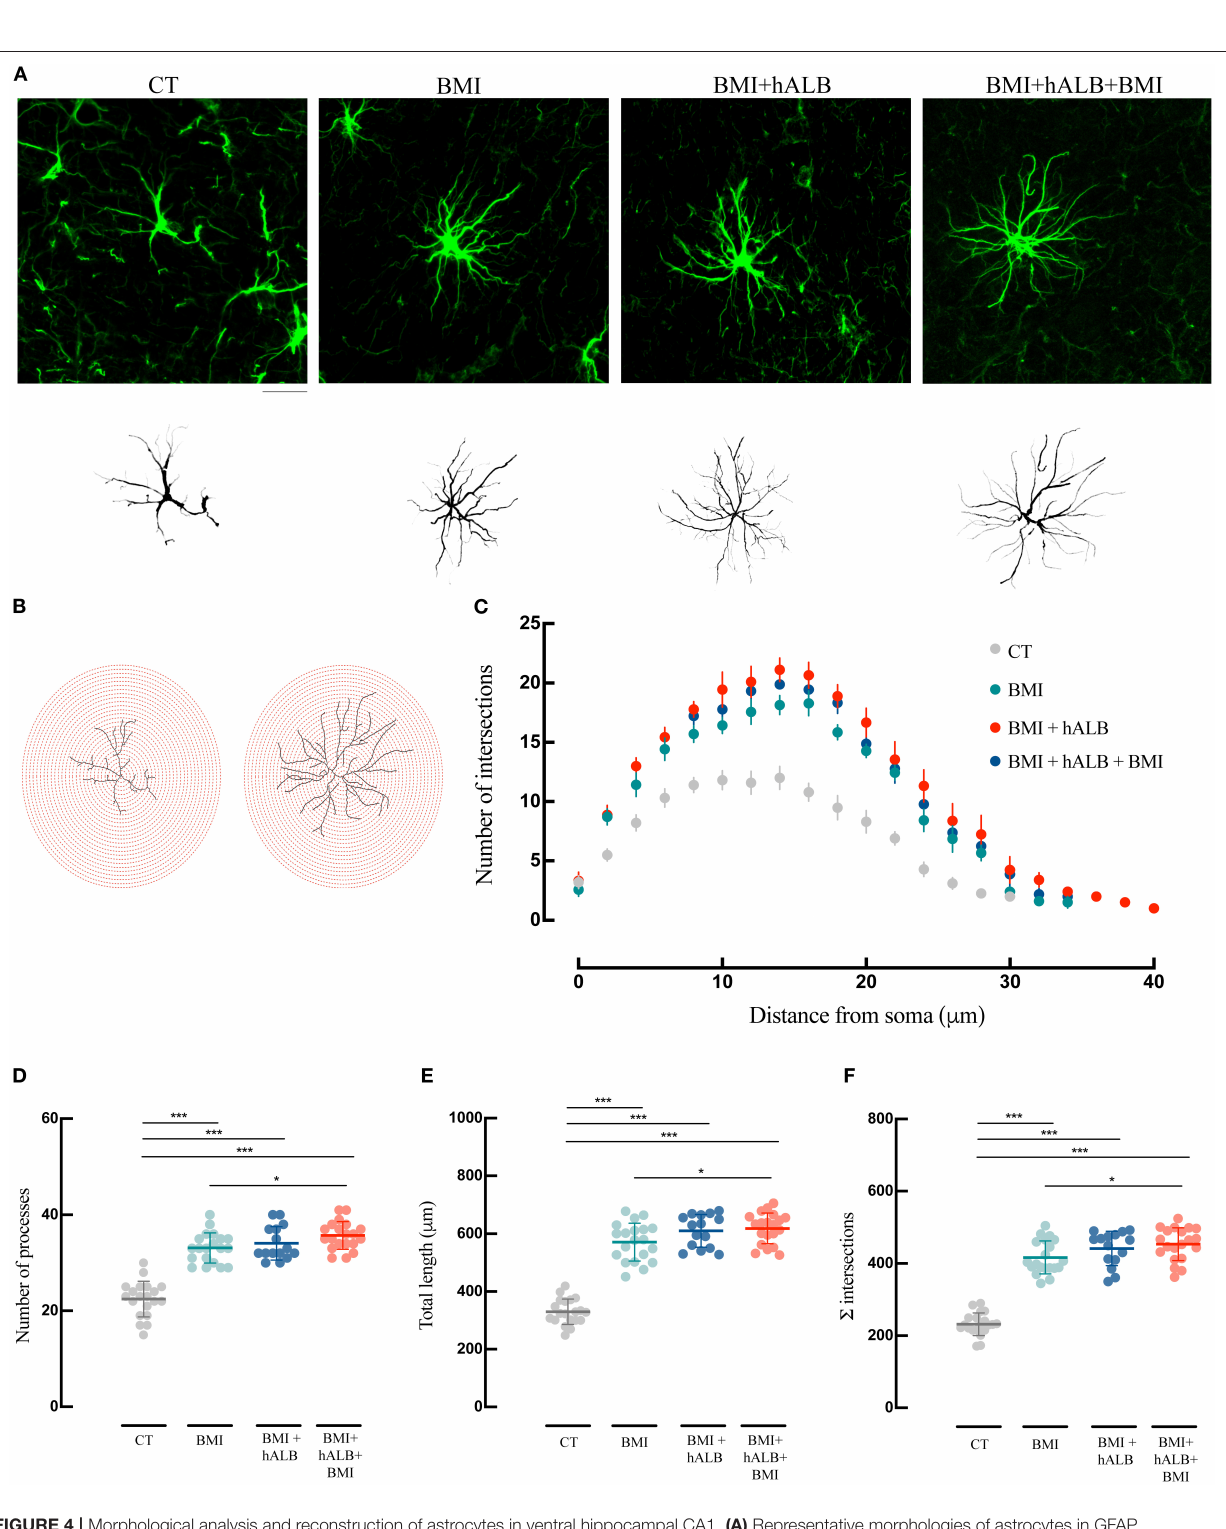
FIGURE 4 | Morphological analysis and reconstruction of astrocytes in ventral hippocampal CA1. (A) Representative morphologies of astrocytes in GFAP immunofluorescence coronal sections of the ventral CA1 hippocampal region are shown for CT, BMI, BMI + hALB, and BMI + hALB + BMI; the correspondent reconstruction of the astrocyte is illustrated in the lower part of the panel. Calibration bar = 20 µ m. (B) Representative Sholl analysis setting of a manually reconstructed astrocyte from CT (left) and BMI + hALB + BMI (right). The circles centered around the soma are separated by radial intervals of 2 µ m. (C) Number of intersections per 2 µ m radius plotted against the distance from the cell soma in CT, BMI, BMI + hALB, and BMI + hALB + BMI animals. (D) Number of processes per 2 µ m radius of astrocytes in CT ( n = 20 cells), BMI ( n = 20 cells), BMI + hALB ( n = 15 cells), and BMI + hALB + BMI ( n = 20 cells) animals. (E) Total length in µ m